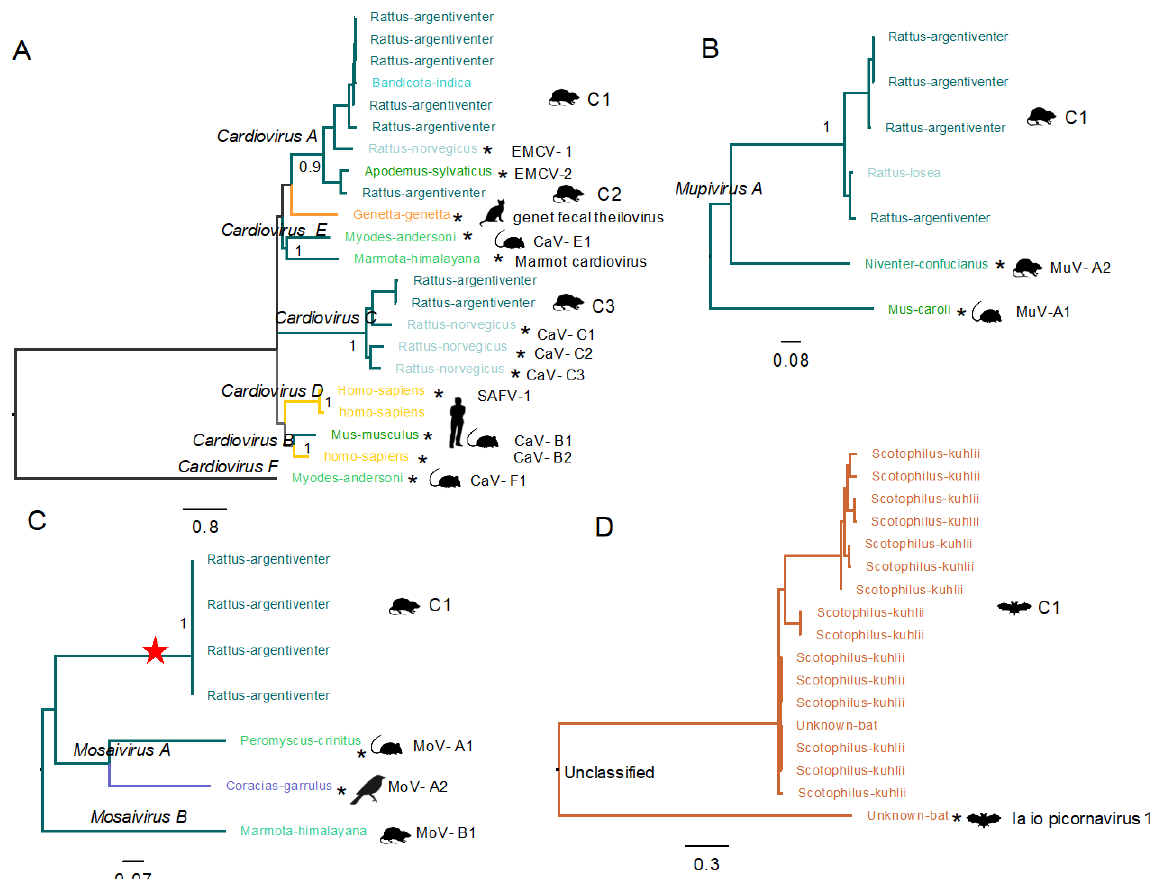
Figure 7. Phylogenetic relationships between picornaviruses found in rats, bats, and other hosts. ( A ) Cardiovirus, ( B ) Mupivirus, ( C ) Mosavirus and ( D ) unclassified picornavirus. Maximum likelihood tree of VP1 sequences detected in Vietnam and reference sequences in NCBI (highlighted with an asterisk). Virus species are labelled on the nodes. Different host species are indicated on the tips and distinguished by colours and symbols; sequences from the clusters found in Vietnamese are labelled on the right. The internal node of members of a putative novel mosavirus species is highlighted with red star.